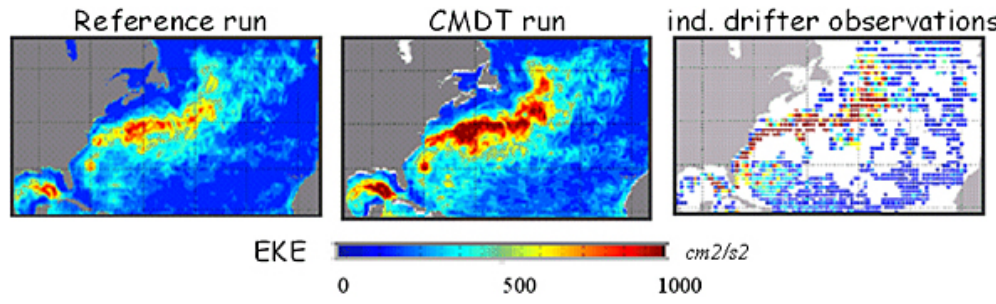
Fig. 4. Mercator 6 months EKE in the Gulfstream area computed from the reference run (left), the run using an observed CMDT (middle) and from independent drifter observations